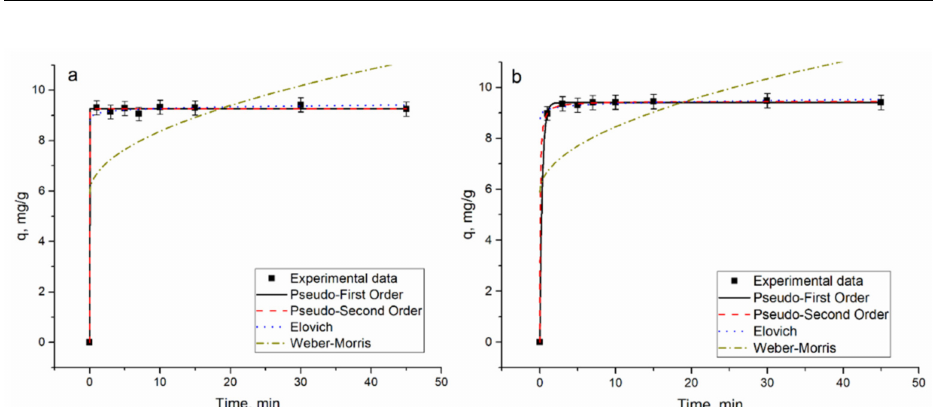
Figure 8. Kinetics of Ce(III) sorption on ( a ) silica SBA-15 and ( b ) titanosilicate ETS-10 sorbents. According to coefficients of correlation values, the sorption of Ce(III) on silica SBA- 15 and titanosilicate ETS-10 sorbents is well described by PFO and PSO models. For both models, theoretically calculated and experimentally obtained values of